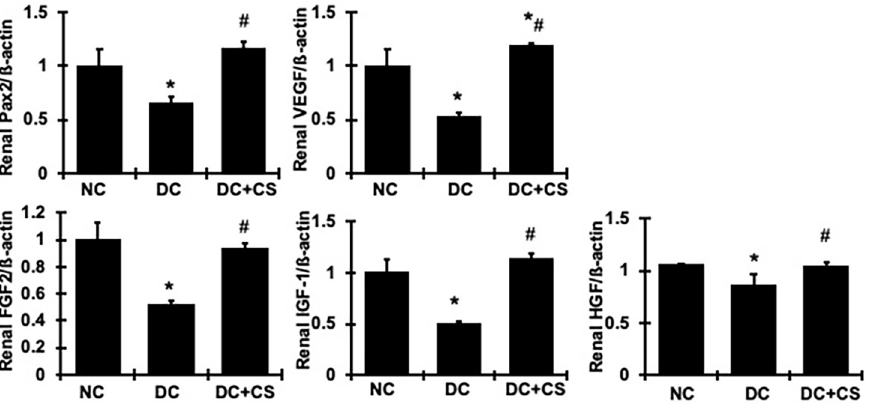
Figure 9. rBMSC sheets ameliorate mRNA expression of regenerative factors in renal cortex tissue of CGN rats. Expression of mRNA was determined by real-time RT/PCR. Changes in mRNA levels were determined by first correcting the amplification of ß-actin for each sample. * vs. normal control rats (NC), p < 0.05; # vs. disease control rats DC, p < 0.05. DC + CS, diseased rats received rBMSC sheets transplantation.